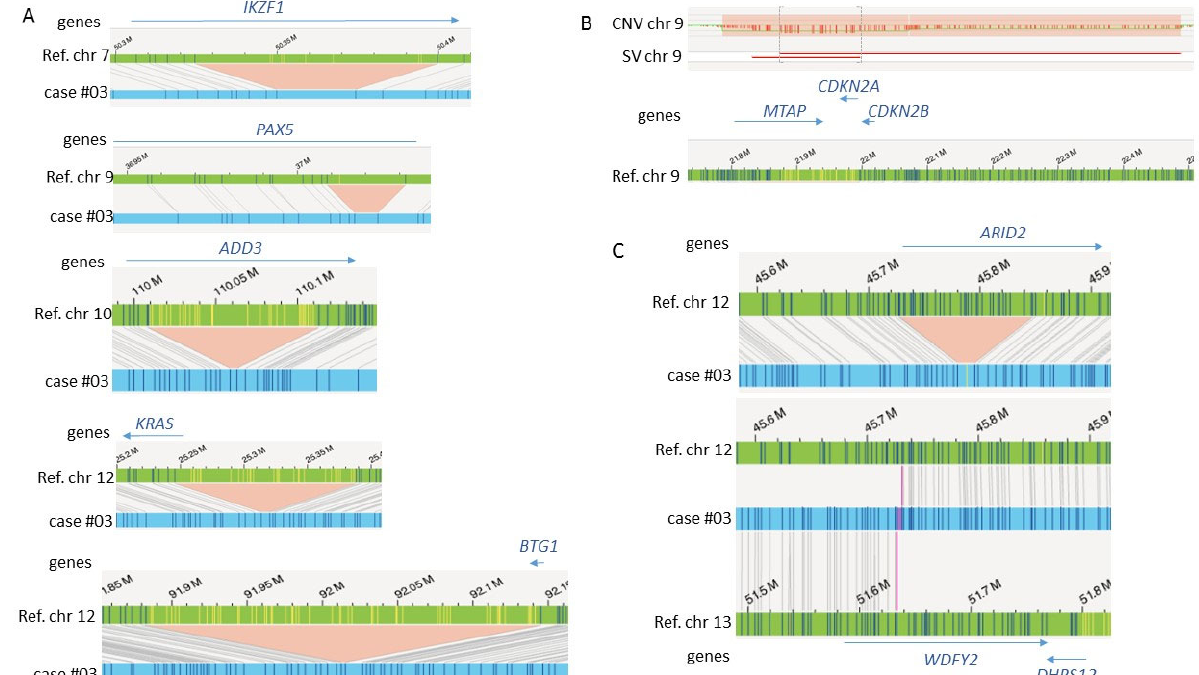
Figure 4. OGM results on case #03. ( A ) Schematic representations showing multiple cryptic deletions of genes of interest. ( B ) At region 9p21.3, the SV track detected two overlapping deletions represented by two different lines (in red) and resulting in a homozygous deletion region (in gray square brackets) inside larger heterozygous deletions. These deletions are visualized by two different levels of the line on the CNV track. ( C ) Schematic representation of the deletion detected by OGM in the ARID2 gene (upper figure) and breakpoint of the t(12;13) localized next to the ARID2 gene (lower figure).